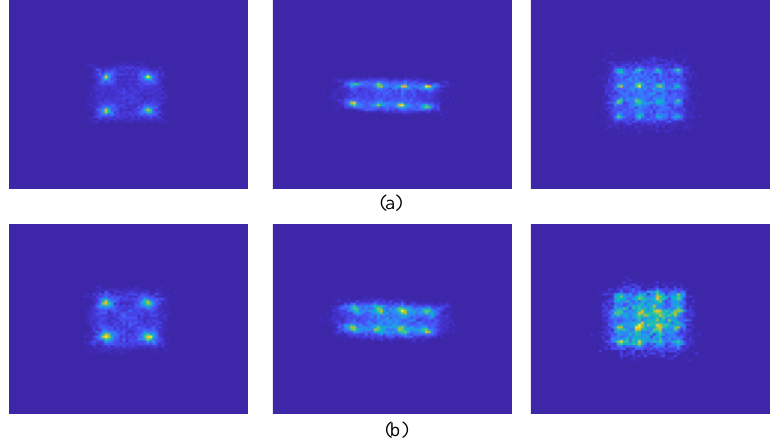
Figure 15. Images of IQH features of QPSK (1st column), 8QAM (2nd column), and 16QAM (3rd column) at: ( a ) CD= 0 ps/nm; ( b ) CD = 400